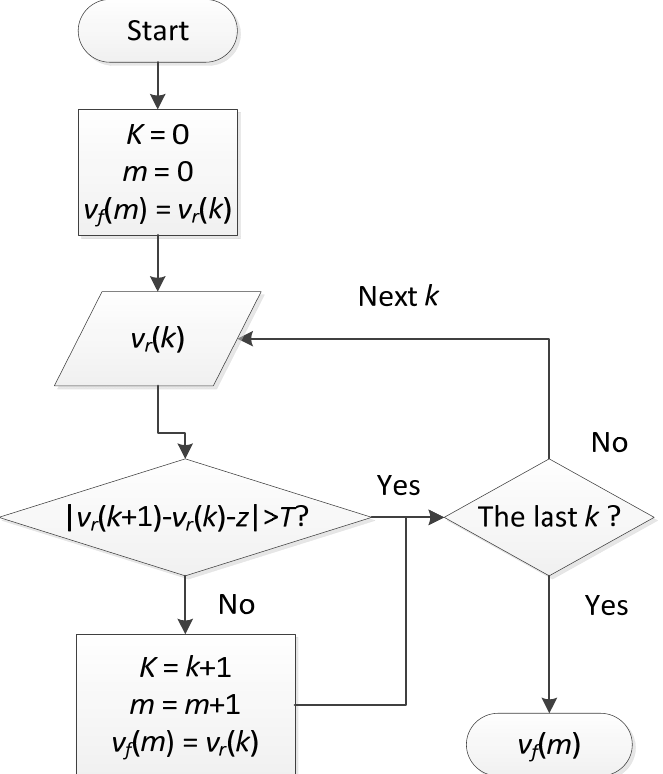
Figure 15. The flowchart of the last step.